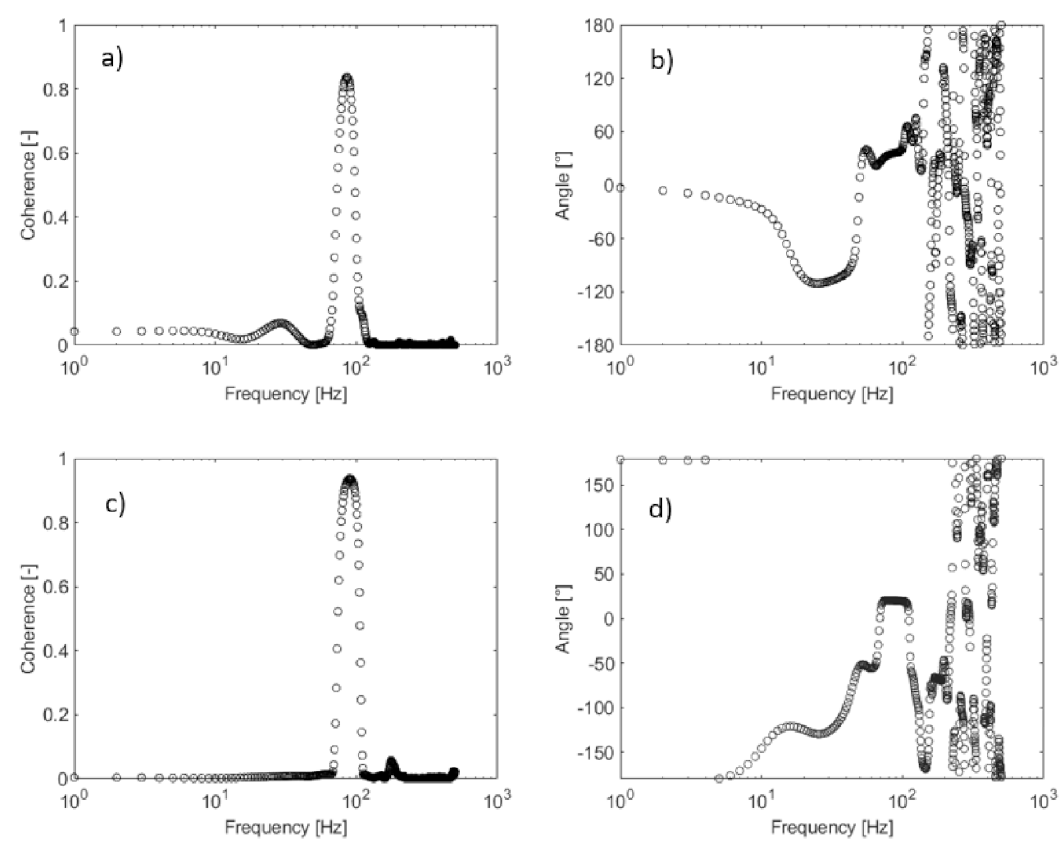
Figure 8. ( a ) First cylinder free to vibrate (Case 10)—Cross-coherence between wake velocity and cylinder acceleration for the reduced velocity equal to 63; ( b ) Phase angle of Case 10. ( c ) Second cylinder free to vibrate (Case 11)—Cross-coherence between wake velocity and cylinder acceleration for the reduced velocity equal to 63 and ( d ) phase angle of Case